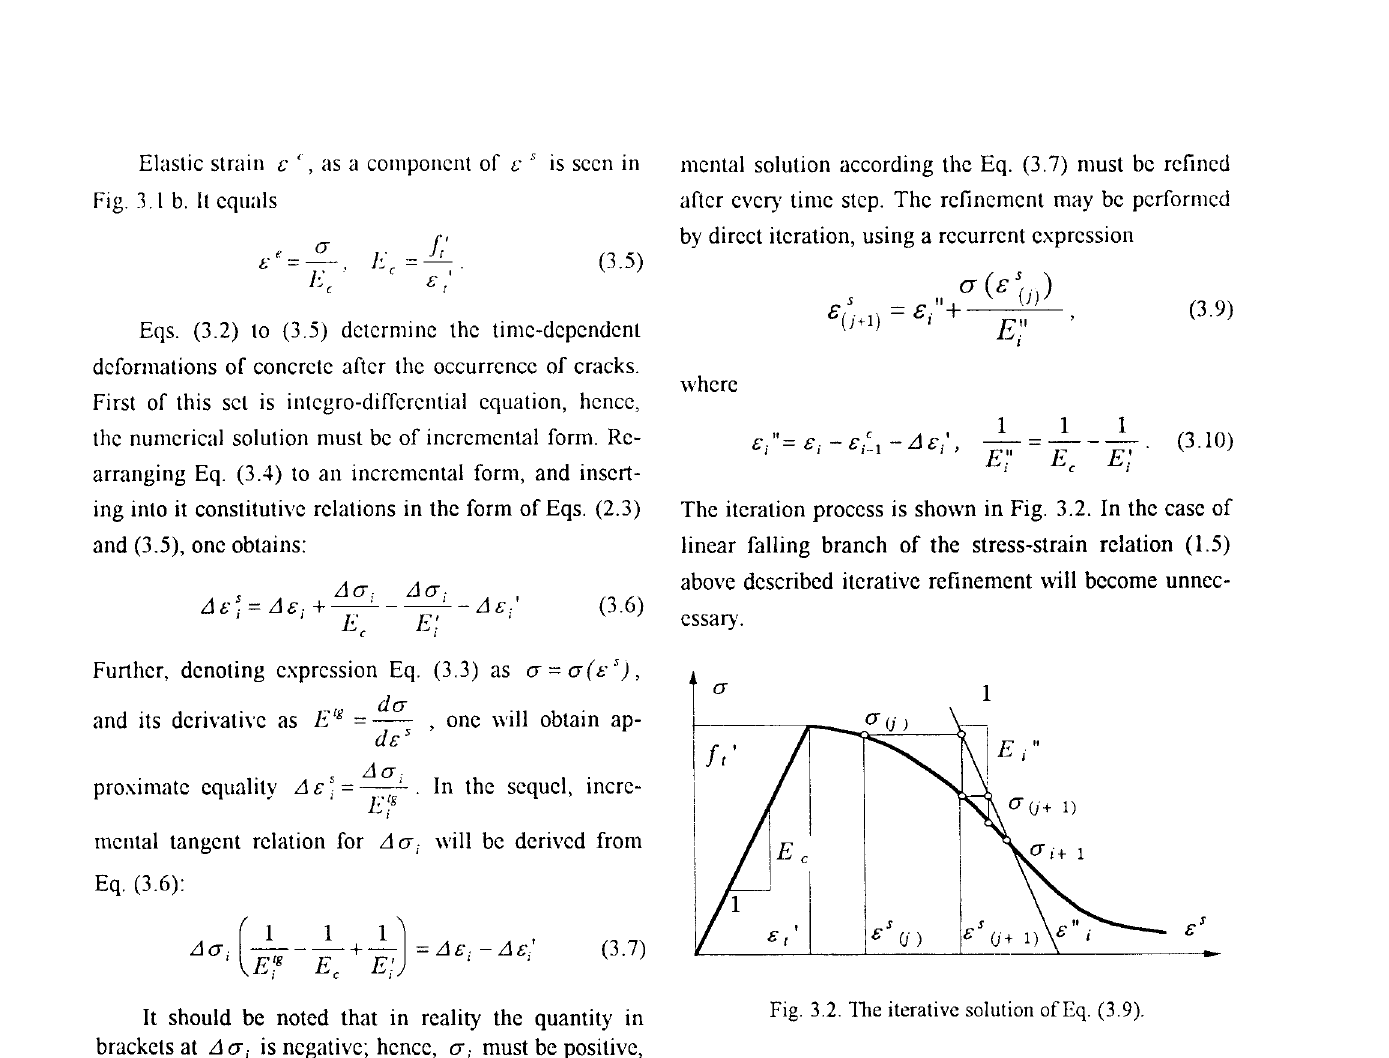
Fig. 3.2. 1be iterative solution ofEq.